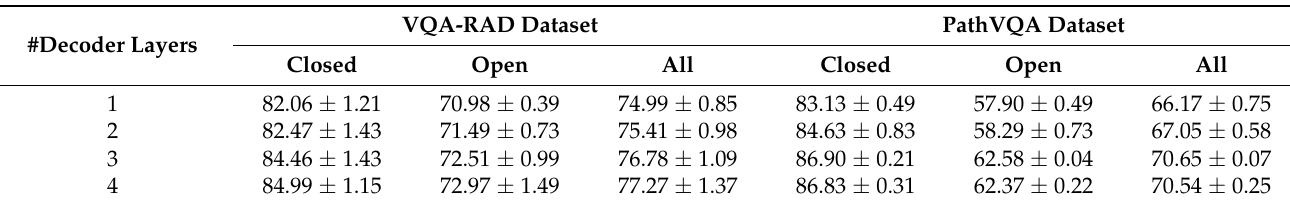
Table 3. Sensitivity analysis with respect to the number of decoder